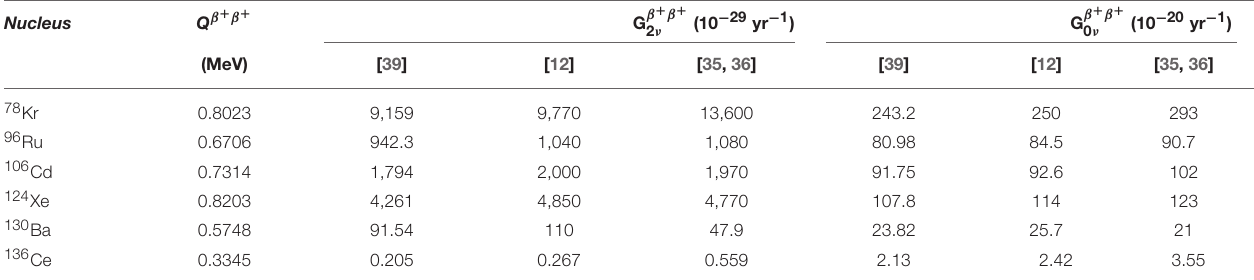
TABLE 5 | PSF for β + β + decay mode.